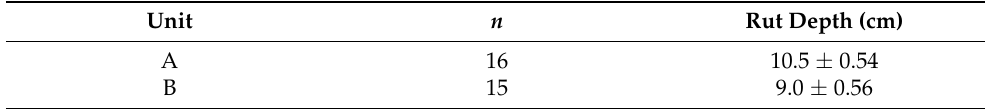
Table 3. Mean rut depth between wheeled and tracked harvester